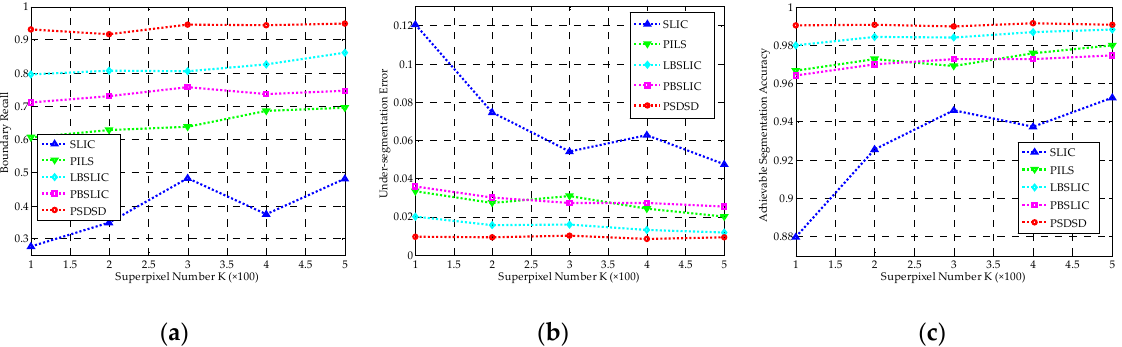
Figure 11. The BR, USE, and ASA results for SLIC, PILS, LBSLIC, PBSLIC, and PSDSD with m set to 8, v set to 0.0075, and K set to from 100 to 500. ( a ) BR; ( b ) USE; ( c ) ASA.